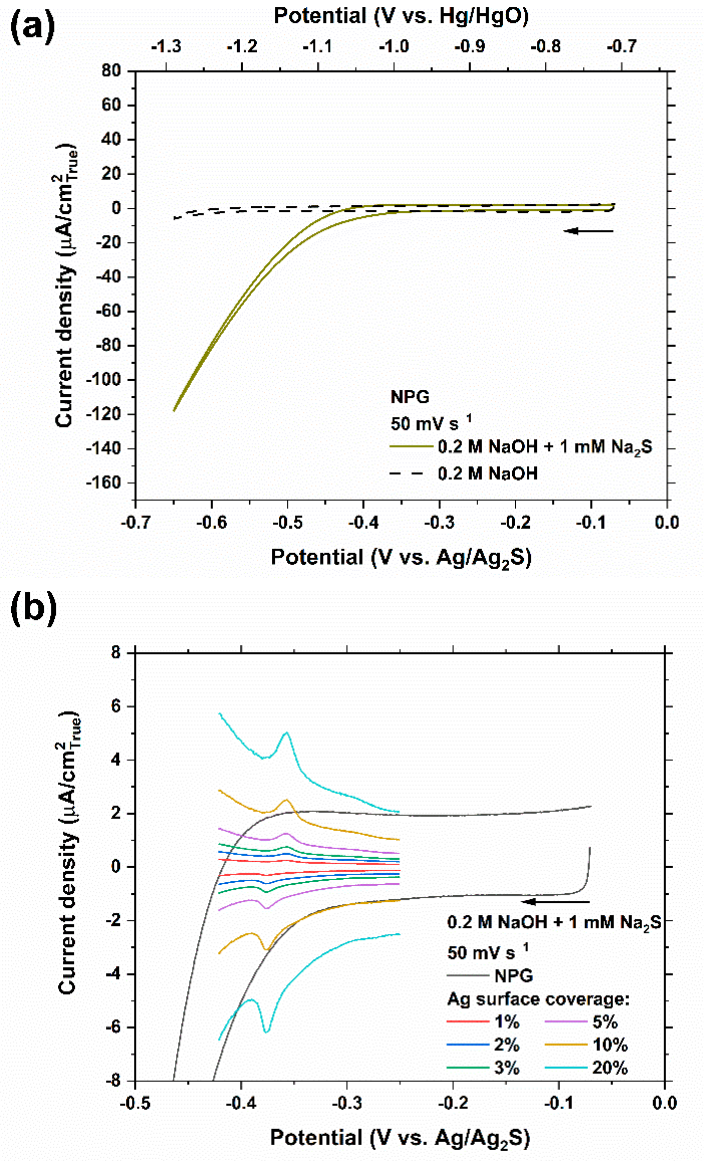
Figure 6. ( a ) Cyclic voltammetry of NPG (from dealloying of as-annealed Ag 95 Au 5 in 0.5 M HClO 4 at 0.3 V MSE to 2.5 C cm − 2 ) in 0.2 M NaOH solution with and without 1 mM Na 2 S at a scan rate of 50 mV s − 1 . True surface areas, as estimated by EIS at OCP in 0.5 M HClO 4 (Figure 5a), have been used to calculate the current densities. ( b ) A more refined scale of ( a ) superimposing the HS − electrosorption peak observed at − 0.37 V Ag/Ag2S on pure Ag electrode adjusted in current density to represent different Ag surface coverages. The arrow indicates the starting point and the scan direction. On a separate note, the overpotential required for HER is considerably lower in the 0.2 M NaOH solutions containing 1 mM Na 2 S on the surface of pure Au, as seen in Figure 3, and on the Au-enriched surface of NPG, as seen in Figure 6. It is more difficult to discern this trend from the measurements on pure Ag or as-annealed Ag 95 Au 5 alloy due to the interference from the current densities associated with the oxidation of AgSH ads into Ag 2 S ads . There are also reports of enhanced proton and water reduction rates on heteroge- neous catalysts composed of noble and/or transition metal sulfides [52–56].